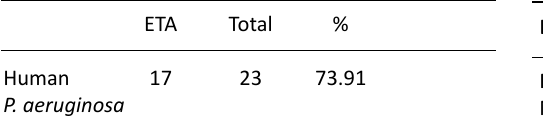
Table 3. Frequency of ETA among human P. aeruginosa isolated from patients with burned skin